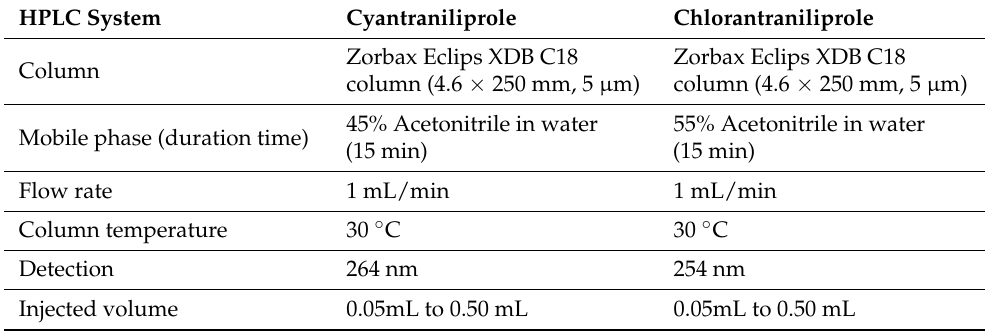
Table 2. Carbon isotope variability of chlorantraniliprole and cyantraniliprole extracted from samples. HPLC System Cyantraniliprole Chlorantraniliprole Zorbax Eclips XDB C18 Column column (4.6 × 250 mm, 5 µ m) Mobile phase (duration time) Flow rate 1 mL/min Column temperature Detection 264